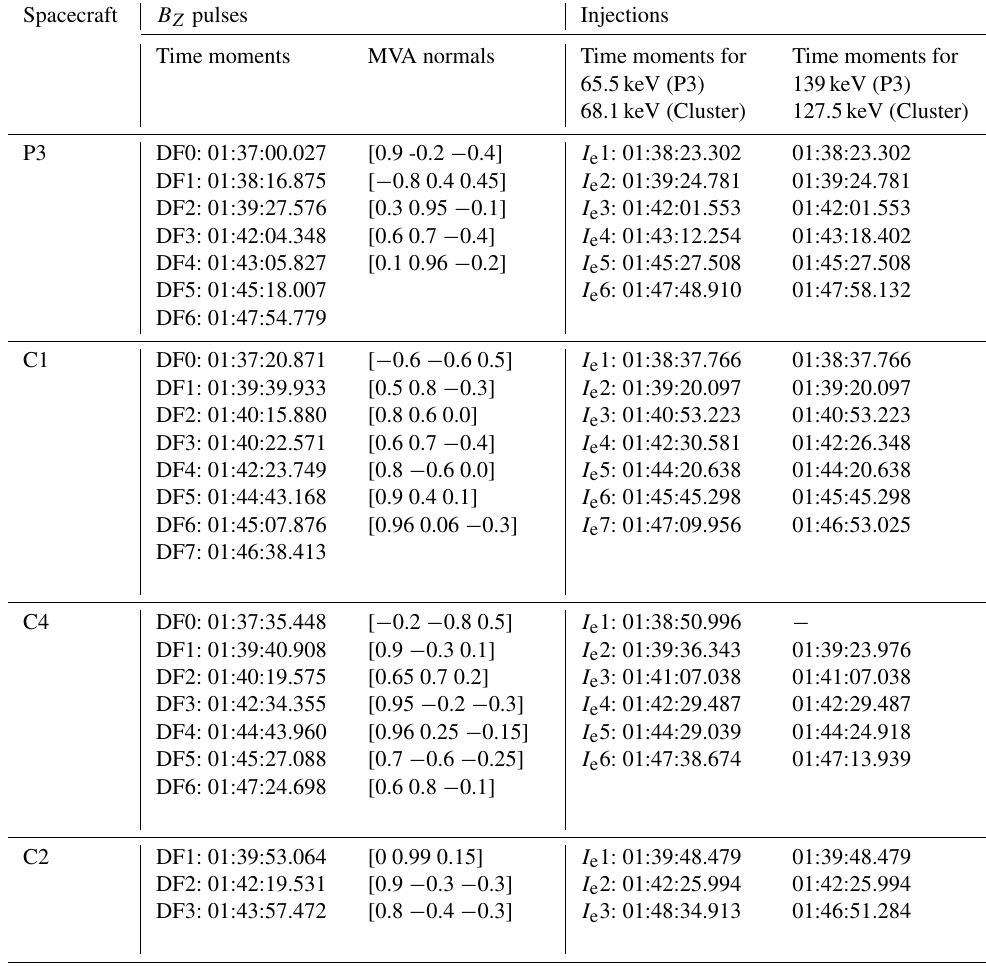
Table 2. Time moments of the B Z pulses (DFs) and electron injections observed by the P3 probe and Cluster spacecraft during dipolarization. Spacecraft B Z pulses Injections Time